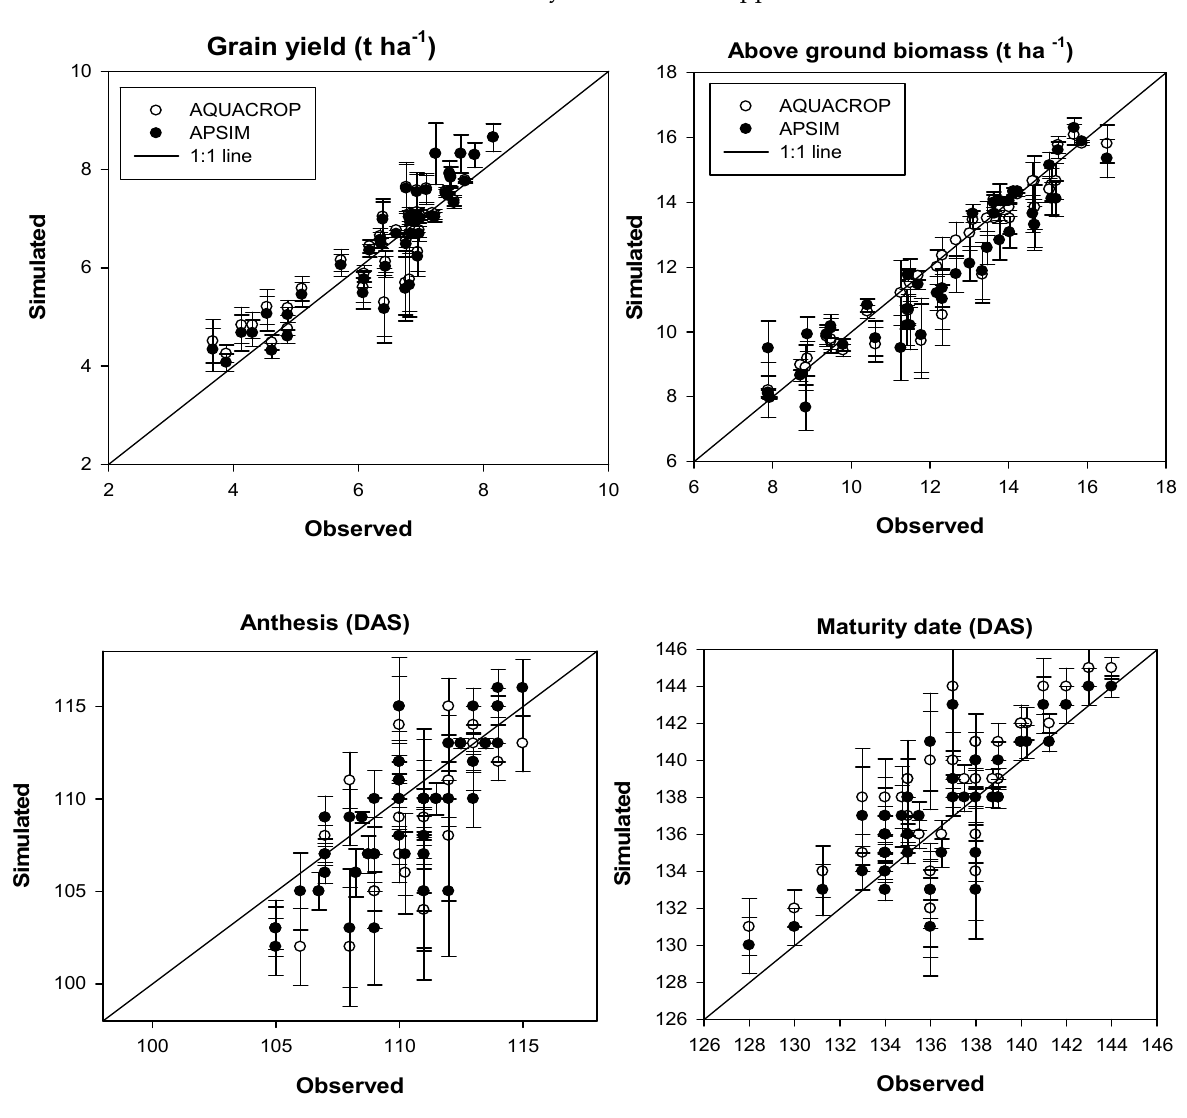
Figure 2. Calibrations of the AQUACROP (opened scatters) and APSIM-Wheat (closed scatters) models subjected to various treatments such as irrigation, fertilization, and sowing date in the Sakha location. Symbols, mean; (error bars, +/– 1 SD). Table 4. Performance indices of AQUACROP and APSIM-Wheat for Sakha 95 spring wheat. Models